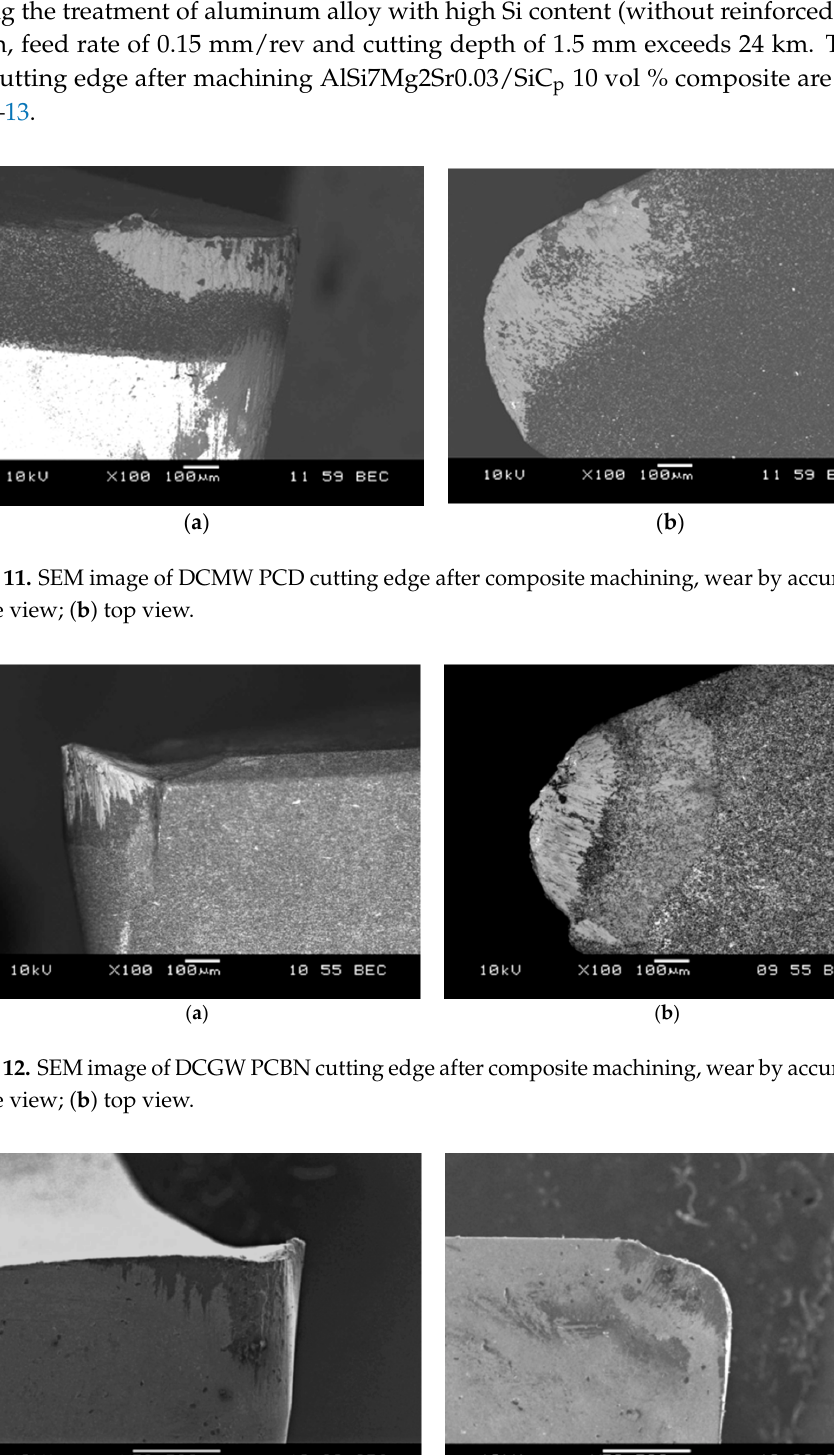
Figure 13. SEM image of CCGX H10 cutting edge after composite machining, wear by attrition: ( a ) side view; ( b ) top view.